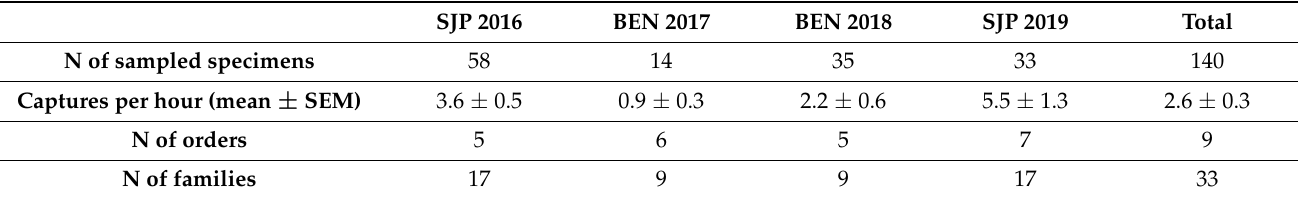
Table 2. Arthropods sampled by timed observations: number (N) of sampled specimens, captures per hour (mean ± SEM) and number of orders and families, reported for each year and site and overall.